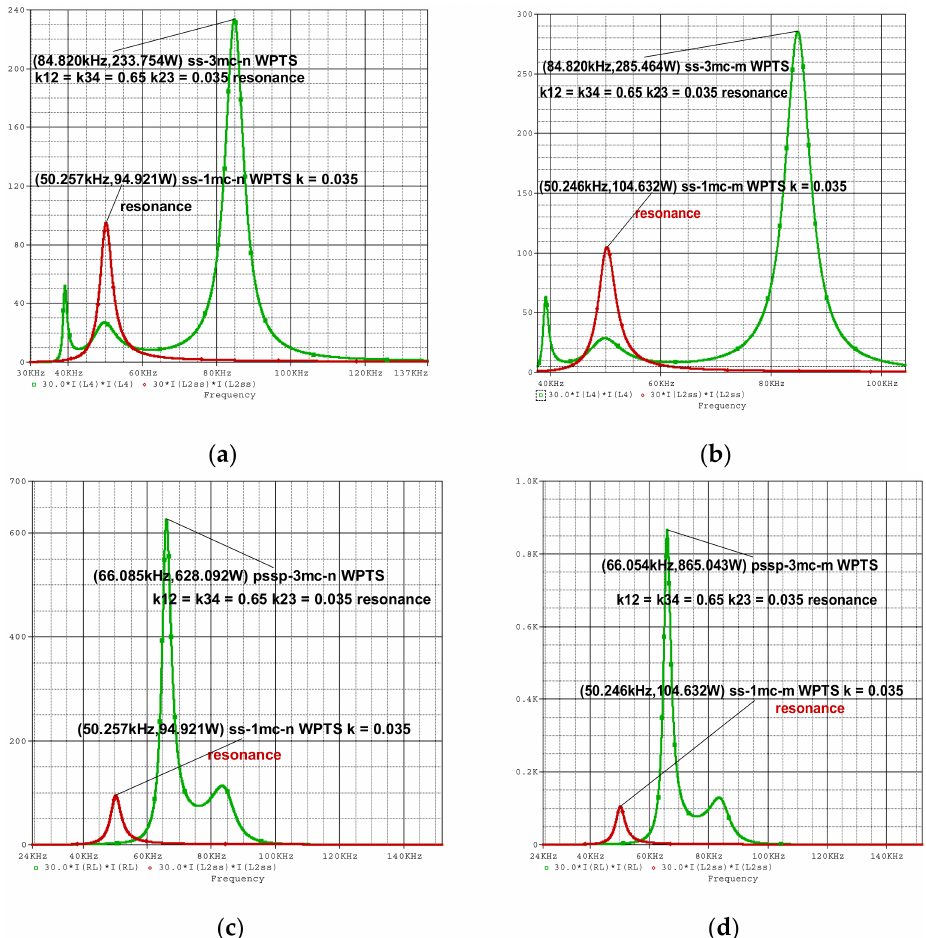
Figure 4. The dependencies on the frequency of the active power delivered to the load P RL for ( a ) Connections ss-3mc-n and ss-1mc-n; ( b ) Connections ss-3mc-m and ss-1mc-m, whereas the